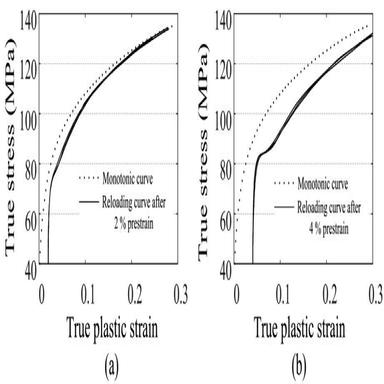
True stress-strain curves in tension along the RD after prestraining in compression to (a) 2% and (b) 4% together with the stress-strain curve for monotonic tension. All curves are plotted up to necking.